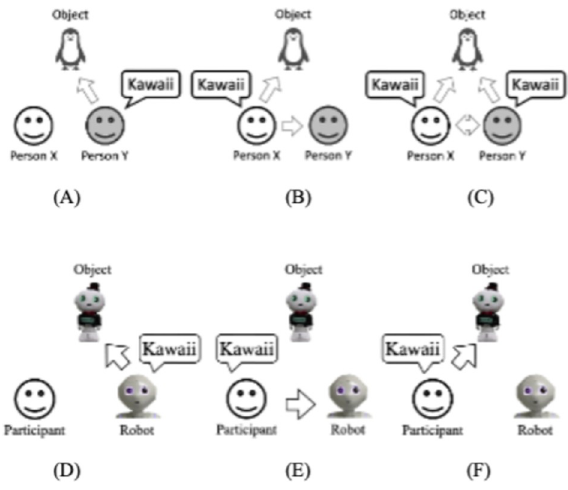
Fig 2. Concept of kawaii triangle [8] and our hypotheses based on